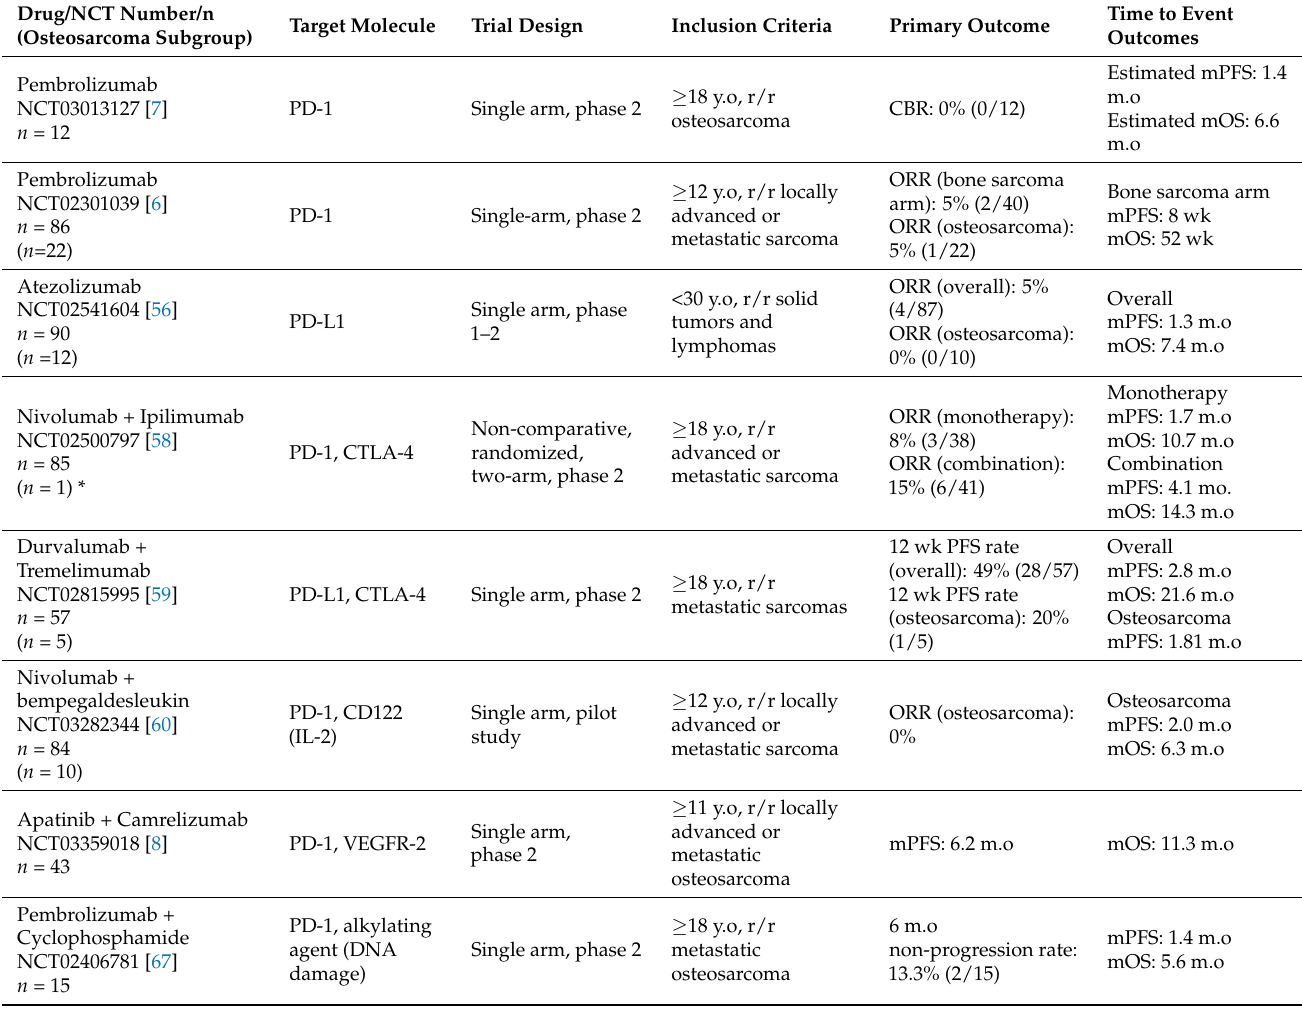
Table 1. Summary of clinical trials assessing checkpoint inhibitors in